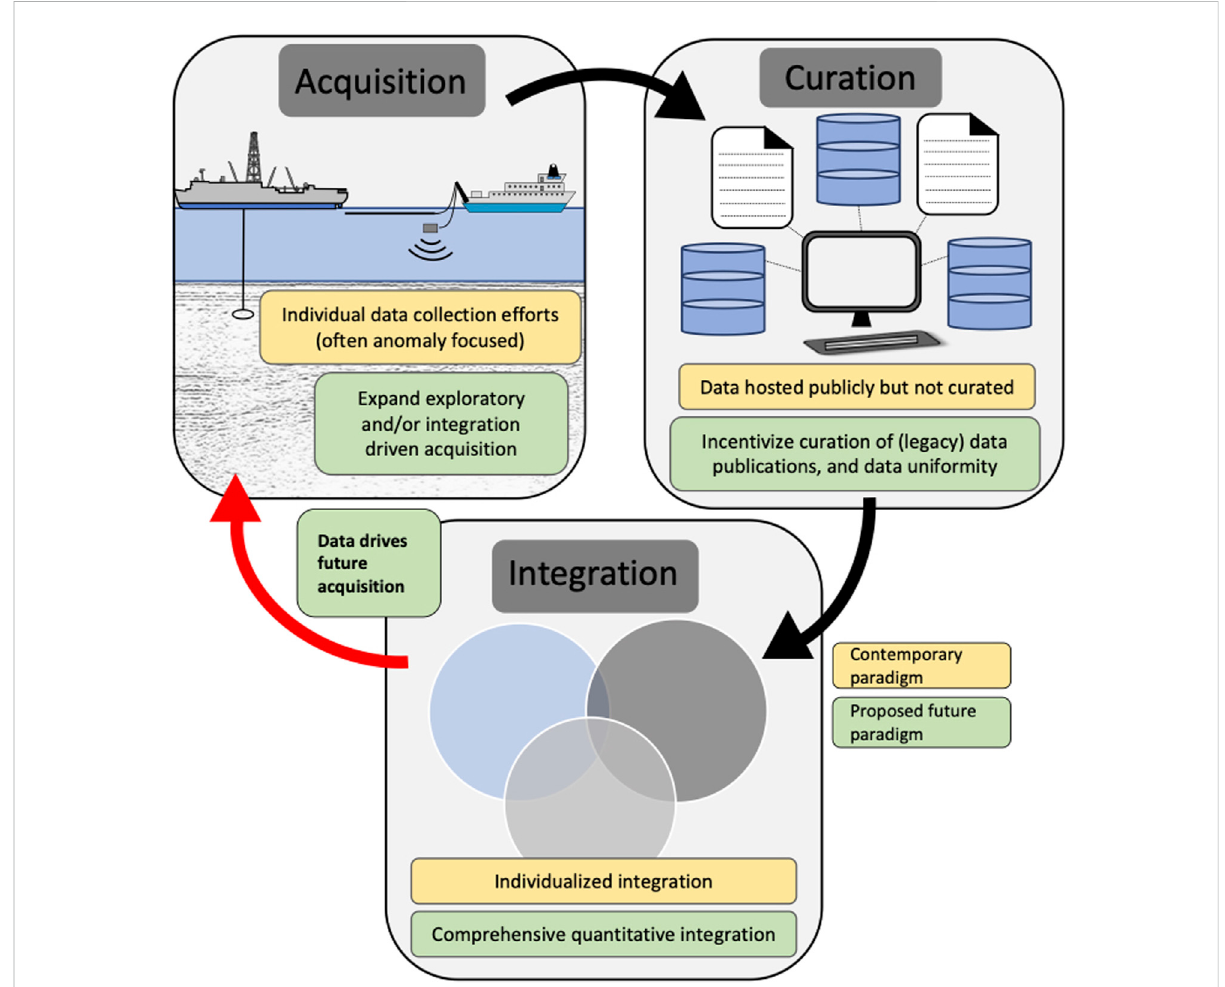
FIGURE 3 Data life cycle in the marine geosciences. Yellow boxes represent the current paradigm of the marine geoscience data lifecycle. Green boxes representapreferablefuturedatalifecycle.Inthenewdatalifecycledataundergoesacompletecircle(indicatedbyredarrow),wherethedatadrives acquisition